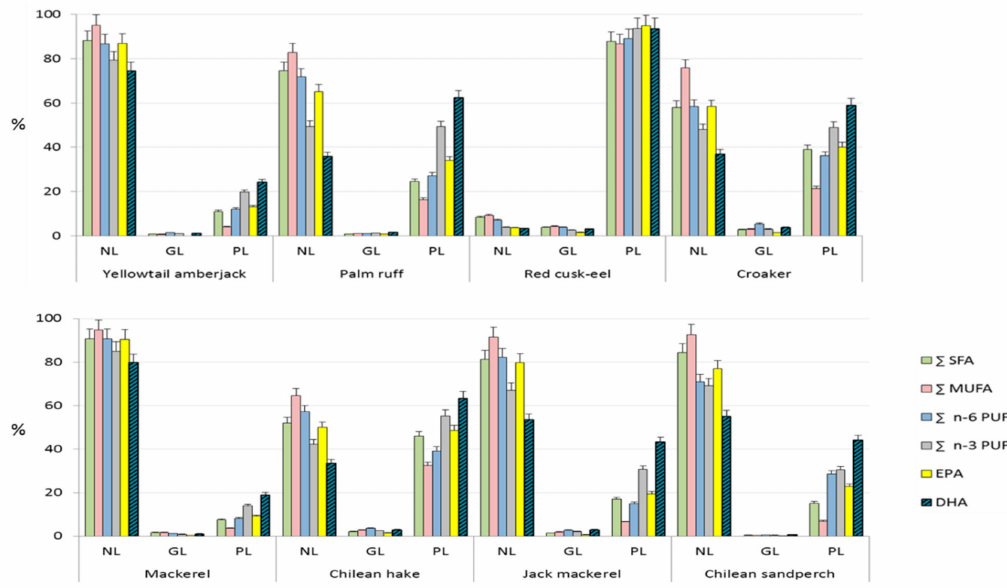
Figure 2. Distribution (% in each lipid class of total lipids) of SFA, MUFA, n-6 PUFA, n-3 PUFA, EPA and DHA among di ff erent lipid classes in extracted fish lipids. Σ n-3 PUFA includes EPA and DHA. Both n-3 PUFA are displayed separately because of their nutritional relevance. NL: neutral lipids; GL: glycolipids; PL: phospholipids.